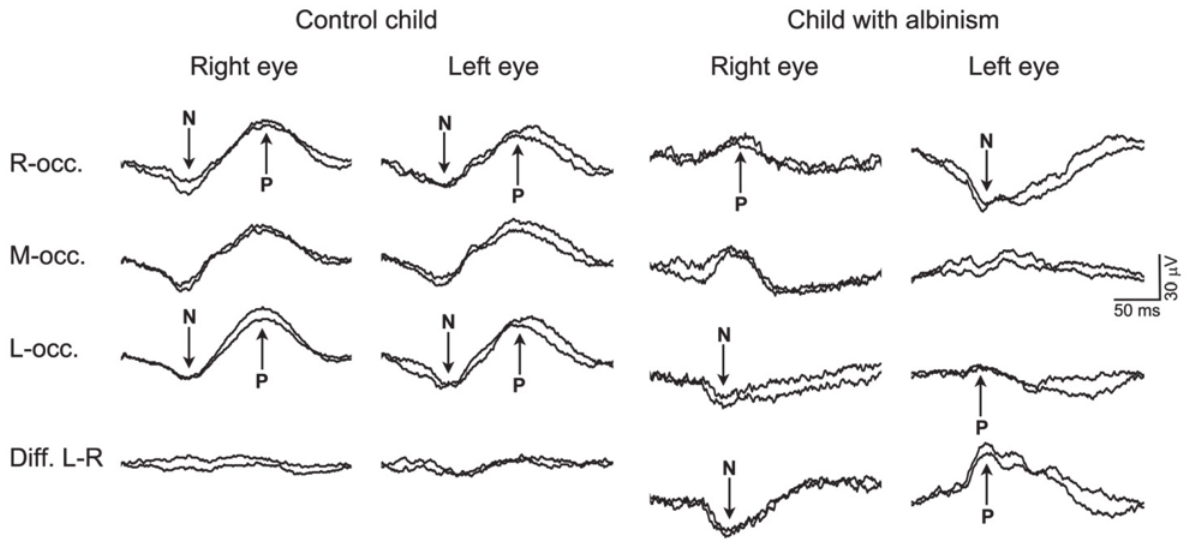
Figure 1: Flash VEP from a control child and child with albinism. In a control child there is a symmetrical distribution of the P and N waves over the lateral two electrodes (R-occ.: right occipital electrode, L-occ.: left occipital electrode) and no deflections of polarity on the differential channel (Dif. L-R), representing the difference in potentials between the left and right electrodes (subtraction of the right from the left occipital signal). In a child with albinism, there is a marked asymmetry over the lateral two electrodes, with the waves of opposite were compared between the eyes (albi- no crossed asymmetry). From the right eye a positive (P) wave is seen over the right electrode and a negative (N) wave is above the left electrode, while from the left eye the distribution of P and N waves is exactly the opposite. This asymmetry is even more clearly seen on a differential channel, where predominance on the negative wave is seen on the right eye, and a positive one on the left